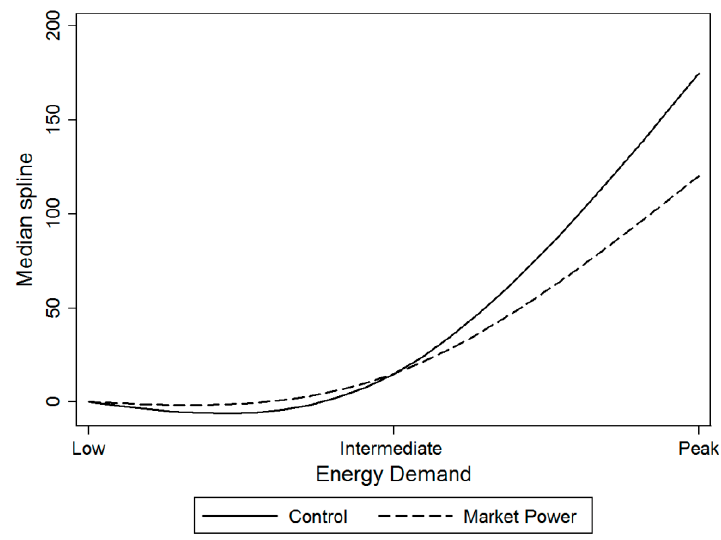
Figure 5. Median spline of treatment effect (no allowance resale).